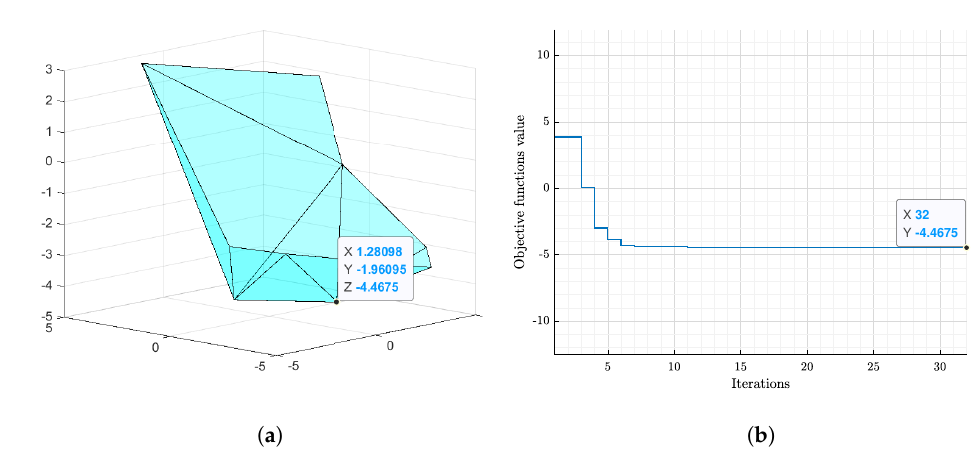
Figure 8. Applying BFGS algorithm to solve the generated convex function landscape when d = 3. ( a ) The figure is a randomly generated convex function landscape. ( b ) Searching curve shows the progress of solving the optimization problem.